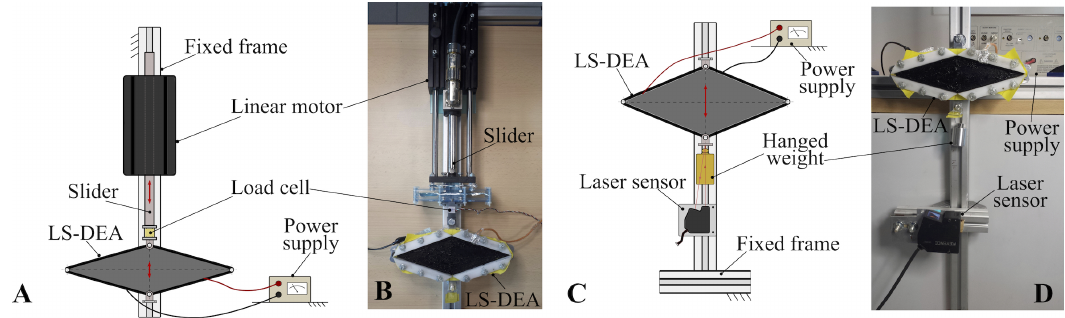
Figure 4. Schematic ( A ) and picture ( B ) of the experimental setup for isopotential and isometric tests. Schematic ( C ) and picture ( D ) of the experimental setup for isotonic